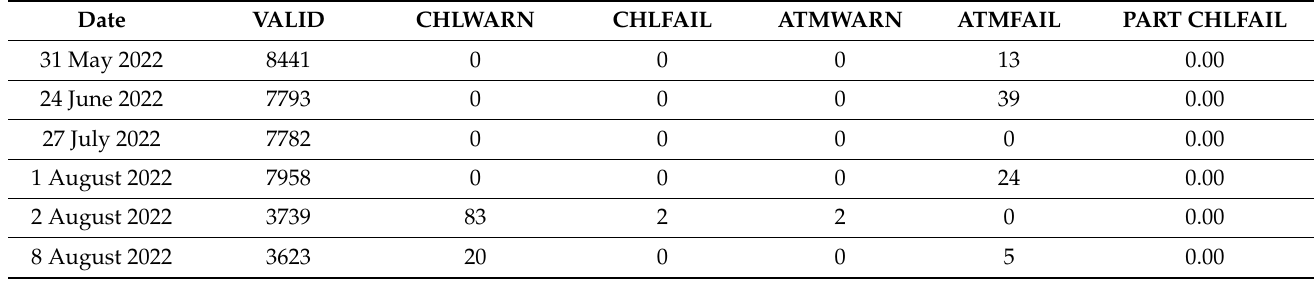
Table 3. The proportion of pixels with CHLFAIL flags based on ac-8 results for S-3A images.